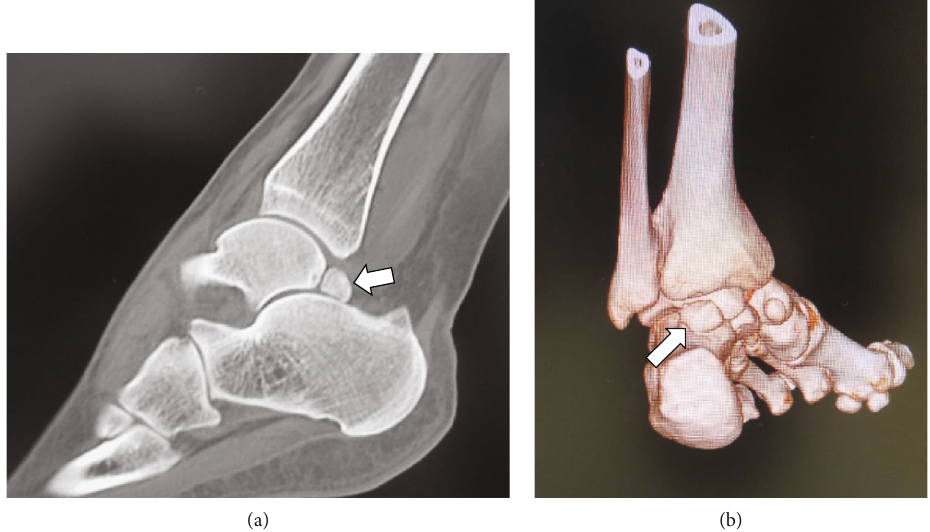
Figure 3: Computed tomography images showing the os trigonum connected to the posterior aspect of the talus. (a) Plain image, sagittal view (arrow). (b) Three-dimensional image, posterior view (arrow).